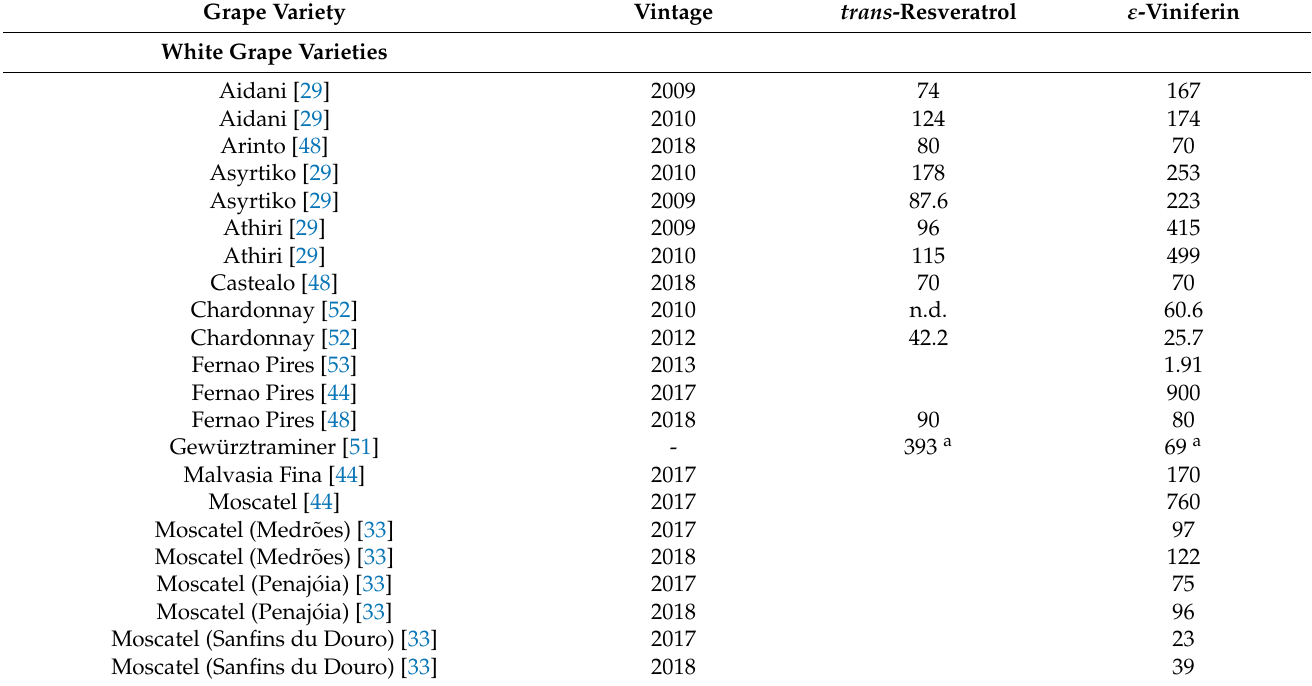
Table 4. Quantification of trans -resveratrol and ε -viniferin in white and red grape varieties (mg/kg DM). Grape